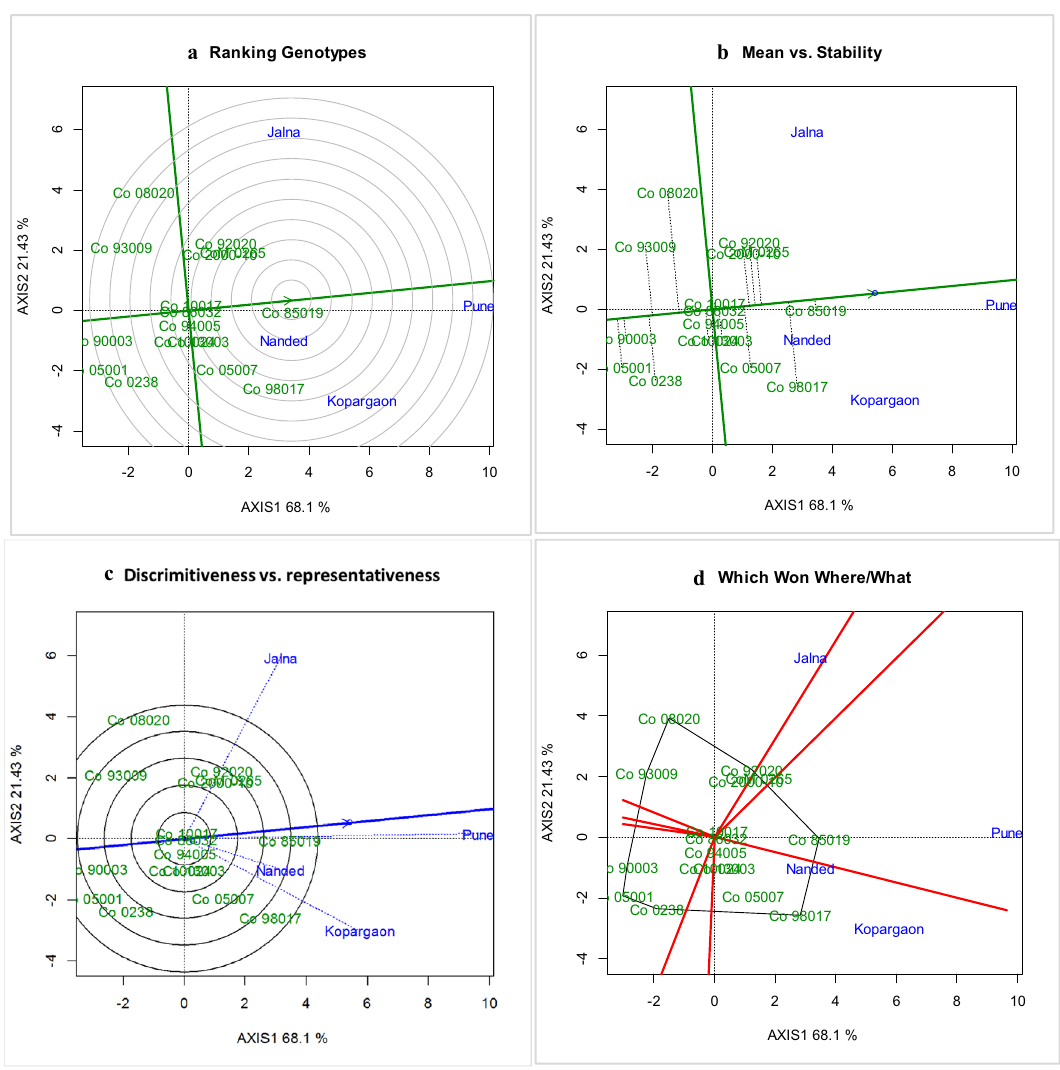
Figure 3. GGE Biplots for CCS yield (t/ha) under tillering phase in drought stress. The data is not transformed, not scaled, environments were centered (Centering = 2) and the biplots based on singular value partition by column metric preserving. The Biplots explained 89.53 percent of G + GE. ( a ) Ranking of genotype GGE biplot depicting the Co 85019 located in first concentric circle as ideal genotype for CCS yield (t/ha), ( b ) Mean vs stability GGE biplot depicting the Co 85019 located in the direction of the average environmental coordinates as best performing genotype for CCS yield (t/ha), ( c ) discriminativeness vs representativeness GGE biplot depicting the longest environment vector and nearer to average environmental coordinates and Pune was identified as highly discriminative environment specific